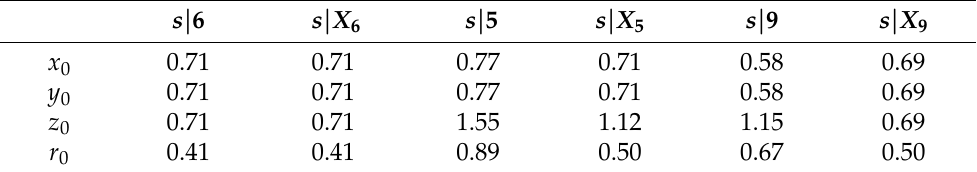
Table 8. Sphere datum location. Estimates of s ( a ) = σ R u ( a ) associated with sphere parameters for three measurement strategies. The first column of two gives the uncertainties calculated using an analytic approximation based on assuming a uniform distribution of points on the sphere or hemisphere while the second column gives the uncertainties based on the actual distribution of